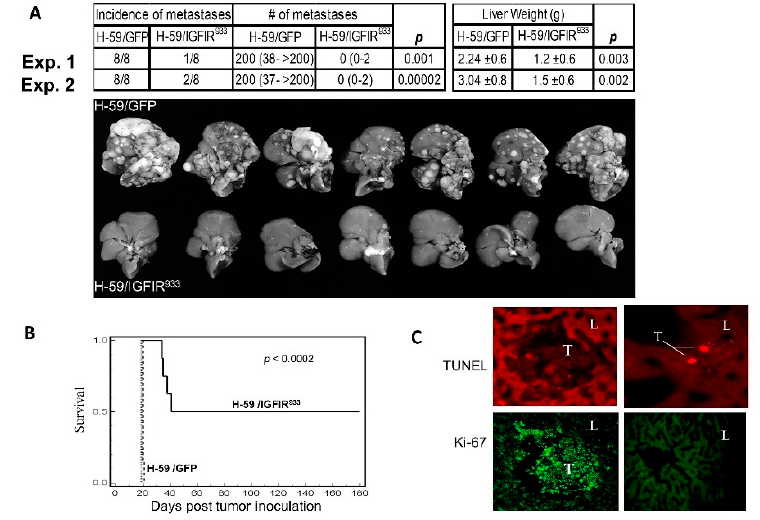
Figure 1. Loss of metastatic potential in lung carcinoma cells expressing a soluble IGF-IR decoy (IGFIR 933 ). Lewis lung carcinoma subline H-59 cells were transduced with retroparticles expressing the truncated 933 aa IGF-IR decoy (H-59 / IGFIR 933 ) or GFP only (H-59 / GFP) and 10 5 tumor cells injected into syngeneic C57Bl / 6 female mice via the intrasplenic / portal route to generate experimental liver metastases. Mice were sacrificed and visible metastases enumerated 14 days later. Shown in ( A ) (top) are the median numbers of metastases (and range) per liver based on eight animals per group in two separate experiments. Liver weights (means ± SD) are shown on the right, and representative livers from experiment (Exp.) 2 are shown on the bottom. Shown in ( B ) are survival data for mice inoculated in a similar manner ( p < 0.0002) and in ( C ) terminal deoxynucleotidyl transferase (Tdt)-mediated nick end labeling (TUNEL) assay (top) and Ki-67 staining (bottom) performed on liver (L) cryostat sections